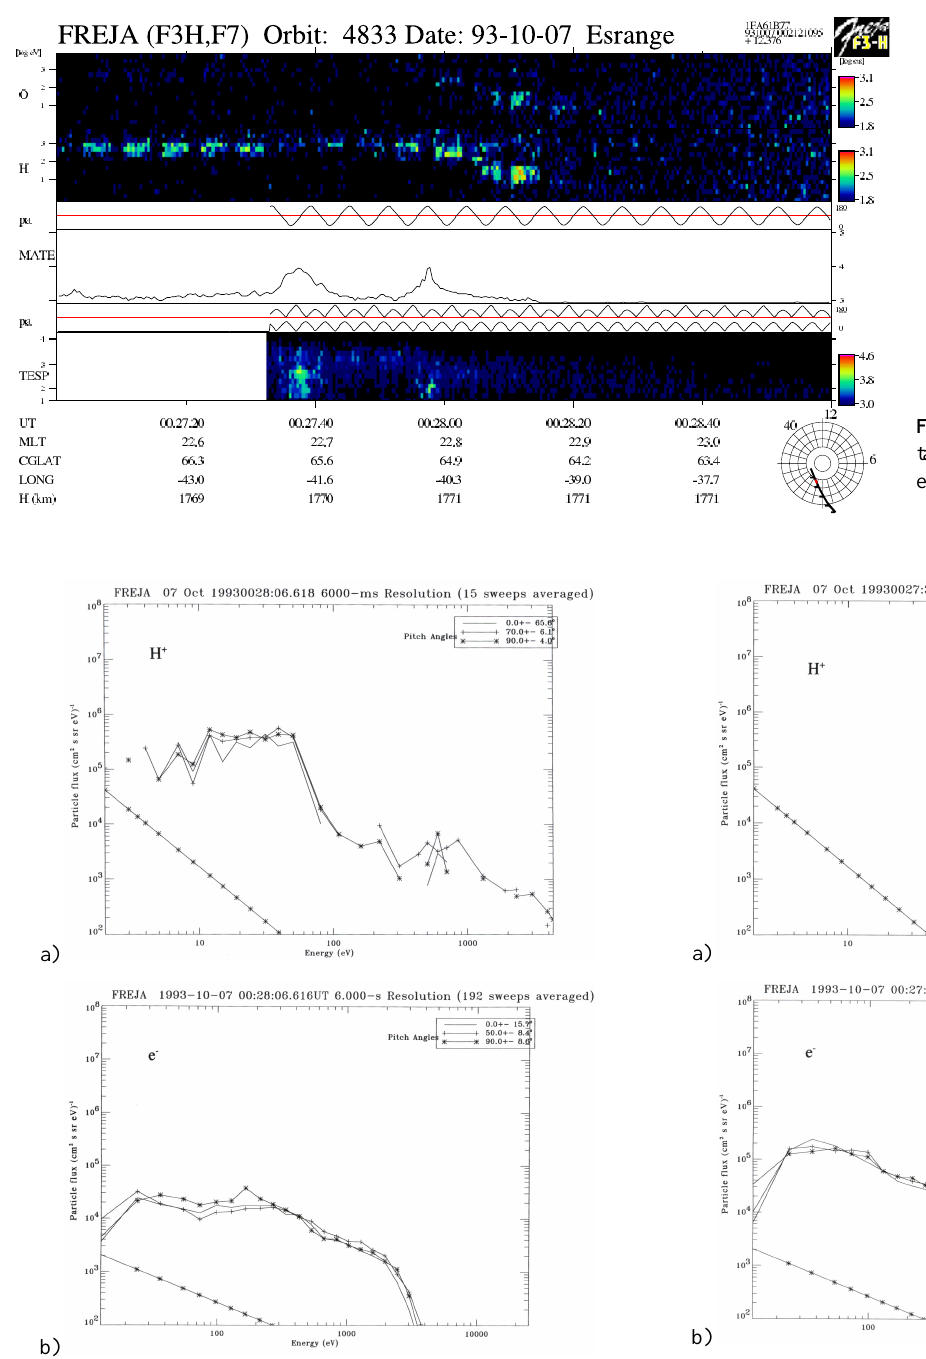
Fig.16. Measured energy spectra of H + ions (a) and energetic elec- trons (b) when the ion energy was very low as shown in Fig.15. The straight lines show the 1-count levels.